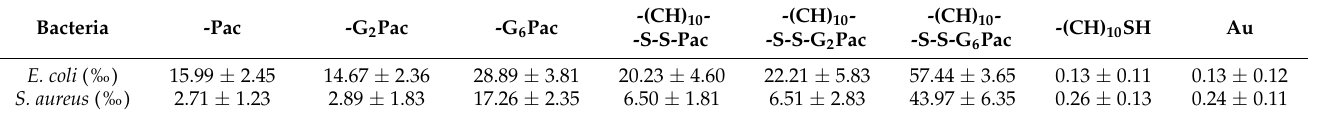
Figure 6. The intracellular ROS levels of E. coli ( A ) and S. aureus ( B ) on different SAM substrates after 24 h of culturing. Table 5. Quantitative analysis of fluorescence images of ROS fluorescent area